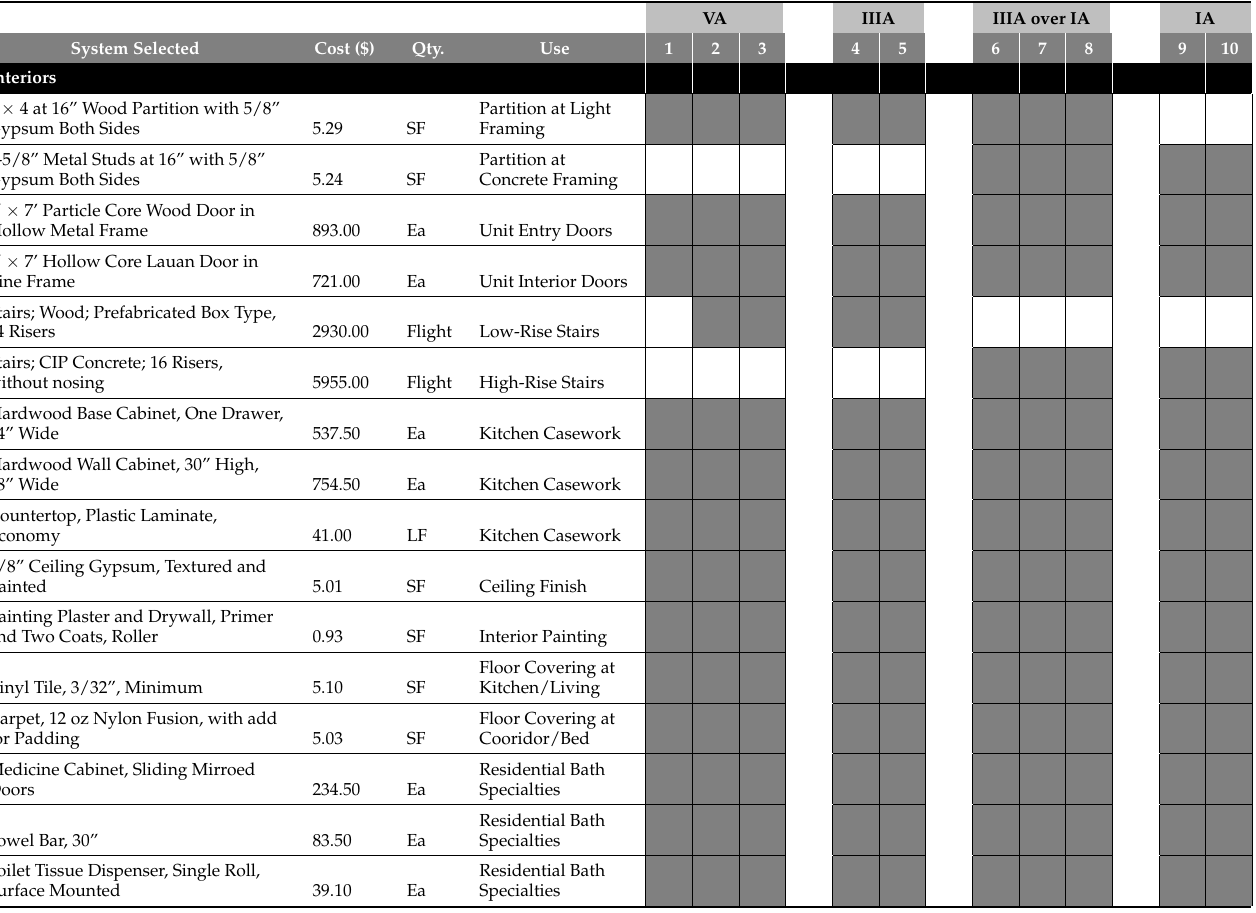
Table 3. Interior Systems, Costs, and Designated